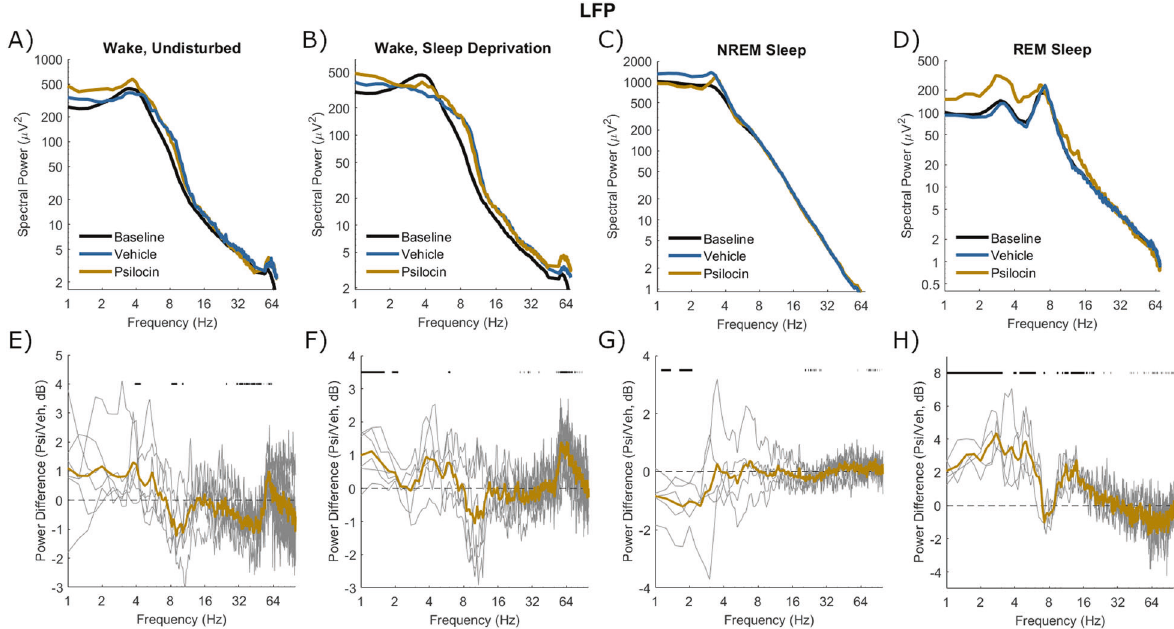
Fig. 7 Spectral power in the mean LFP after vehicle and psilocin injection. The mean power spectra of mean LFP in four different vigilance state conditions following injection with vehicle (blue) and psilocin (yellow). A ) ‘ Wake, undisturbed ’ corresponds to the fi rst experiment, all wake epochs from injection until the fi rst NREM episode at least 1-minute duration. B ) ‘ Wake, sleep deprivation ’ corresponds to the fi rst 30 min of sleep deprivation in the second experiment. C ) ‘ NREM sleep ’ and D ) ‘ REM sleep ’ correspond to the fi rst experiment, all NREM/REM sleep epochs in the sleep period after injection, de fi ned from the start of the fi rst NREM sleep episode at least 1 min duration until the next wake episode at least 5 min duration. Spectra averaged across the same vigilance state in the baseline day are shown for comparison (black). E – H ) Below each plot illustrates the spectral power difference as a function of frequency in decibels between vehicle and psilocin conditions (positive is greater after psilocin). Grey lines correspond to individual animals and coloured lines to the mean. Black lines indicate discrete frequencies (at 0.25 Hz resolution) that were signi fi cantly different ( p < 0.05) according to paired t